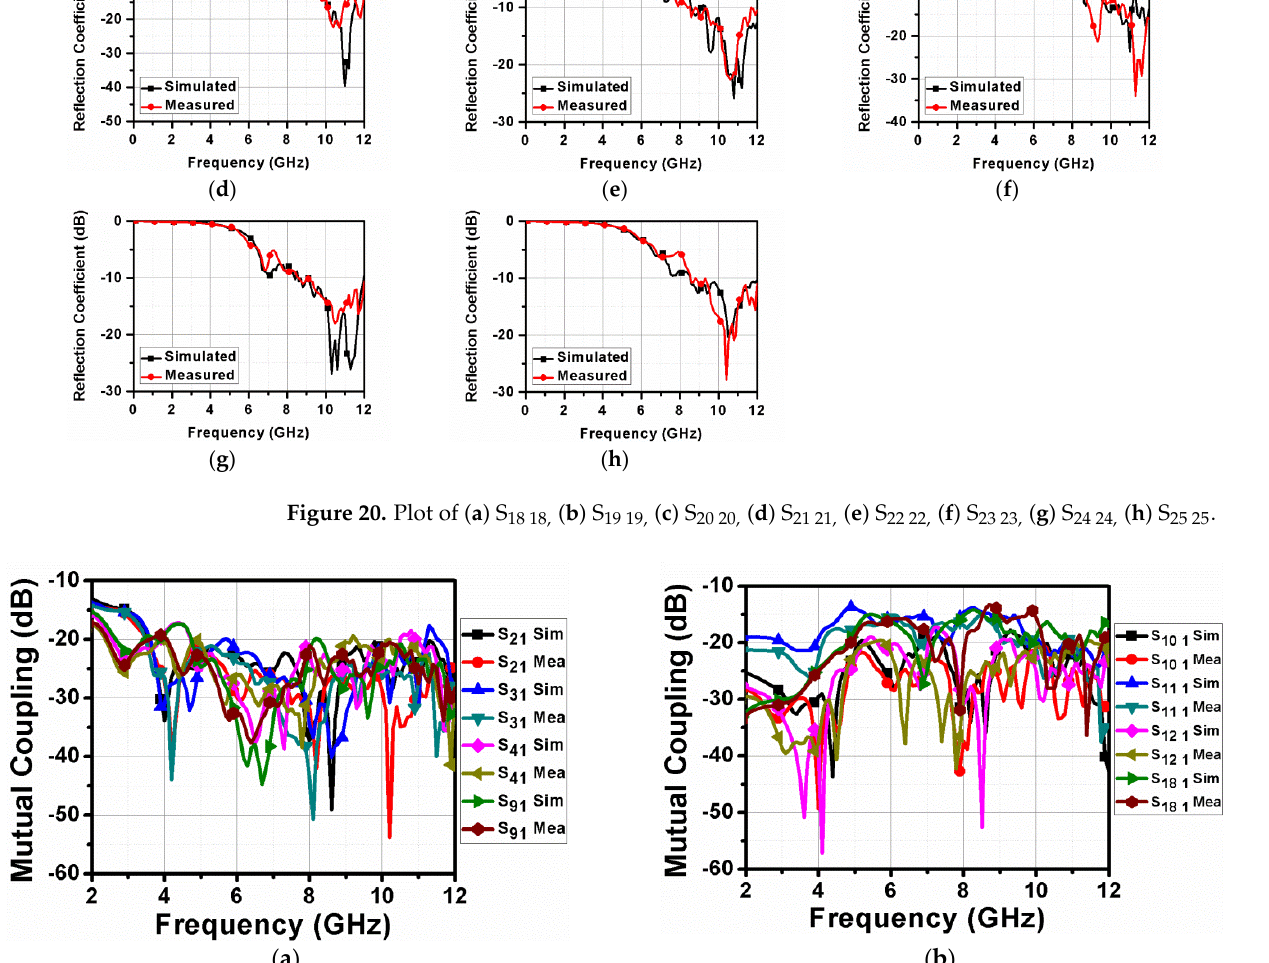
Figure 21. Mutual coupling between sensing and communication antennas ( a ) S 21 , S 31, and S 41 ( b ) S 10 1 , S 11 1 , S 12 1 , and S 18 1 .